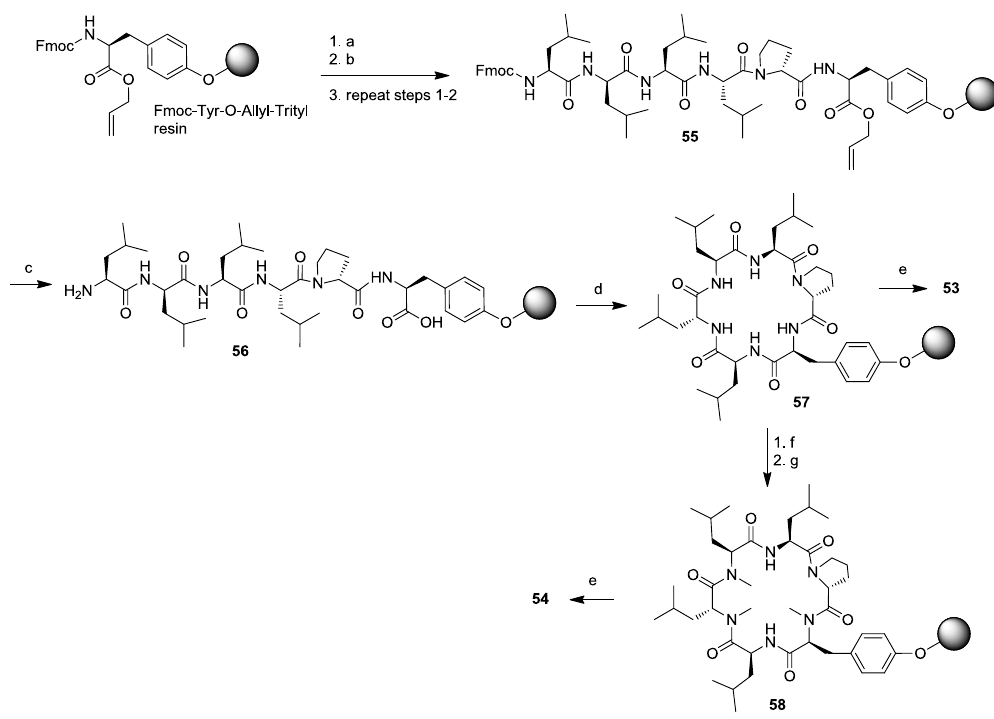
Scheme 10. Solid-phase synthesis of 53 and 54 on trityl resin. Reagents and conditions : (a) 20%